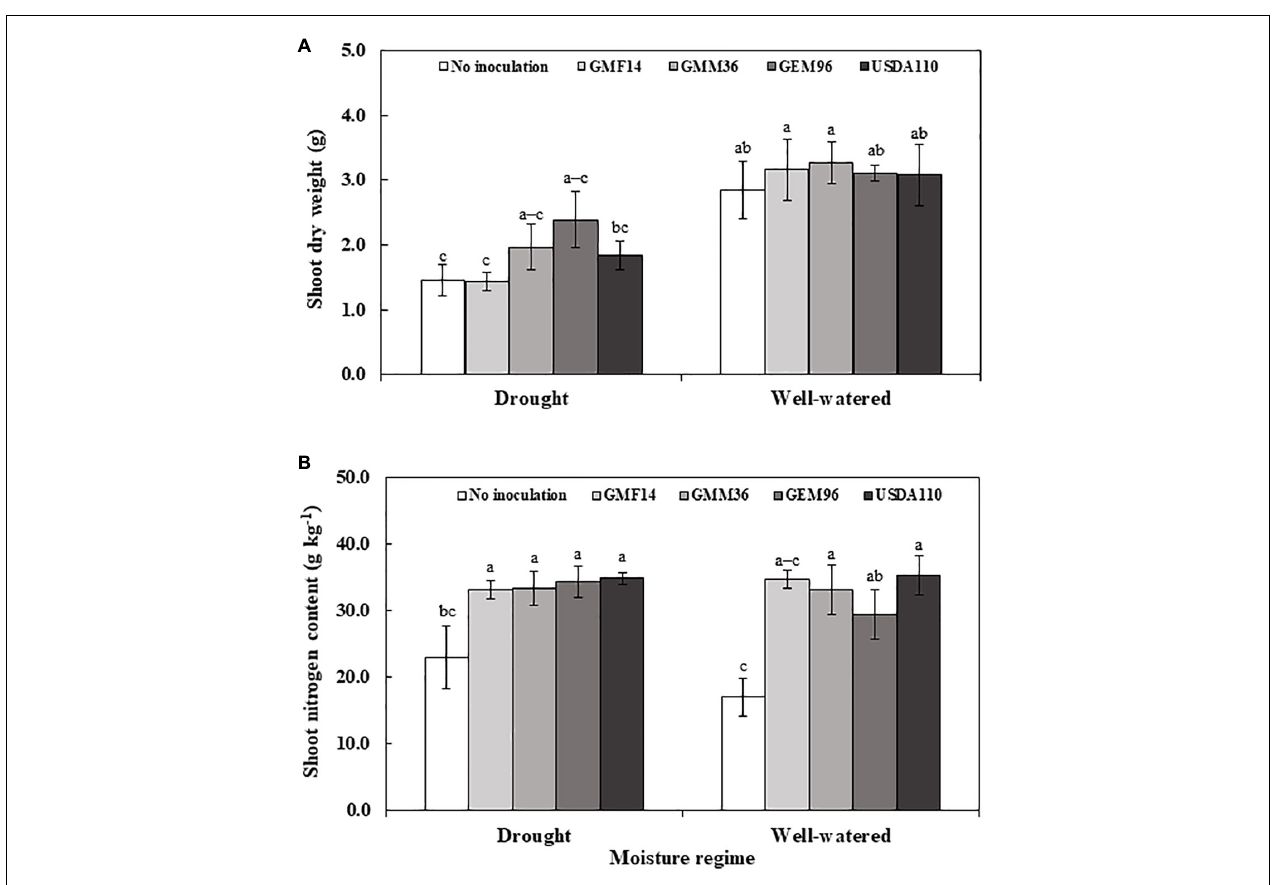
FIGURE 2 | Shoot dry weight (A) and shoot nitrogen content (B) of soybean plant (Cv. sultana) inoculated with different Bradyrhizobium strains in two moisture regimes in the second greenhouse experiment. The error bars are standard deviation of four replications ( n = 4). Values followed by the same letters on each bar are not significantly different at p ≤